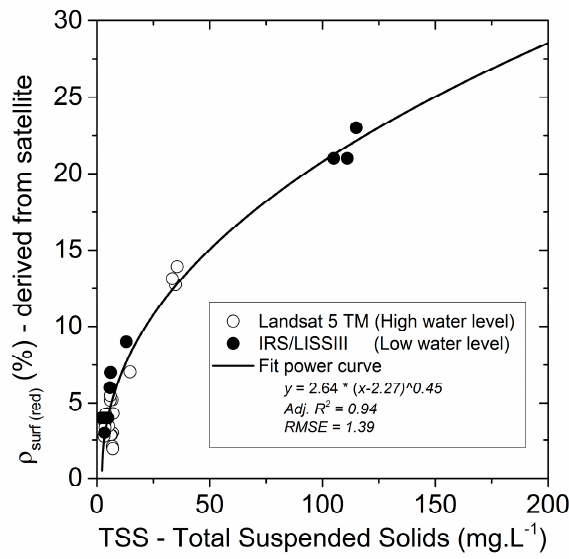
Figure 4. Non-linear fit between TSS ( n = 39, Adj. R 2 = 0.94, RMSE = 1.39) and reflectance (red band) derived from satellite sensors (Landsat TM data for high water level, April 2011; and IRS/LISSIII data for low water level season, September 2012). Adapted from [12].